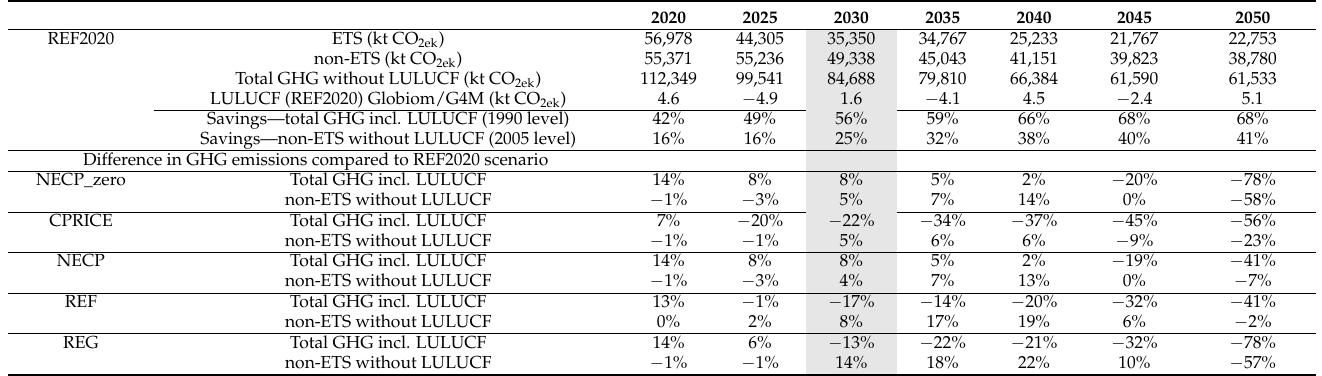
Table 8. GHG emission savings in EC REF2020 and comparison of the scenarios of this study with EC